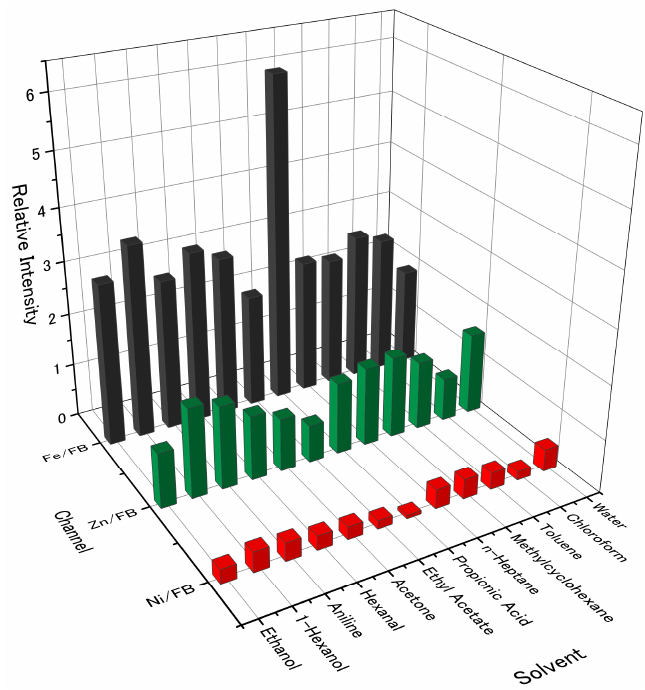
Figure 4. Relative intensity of metalloporphines compared to free-base porphine.